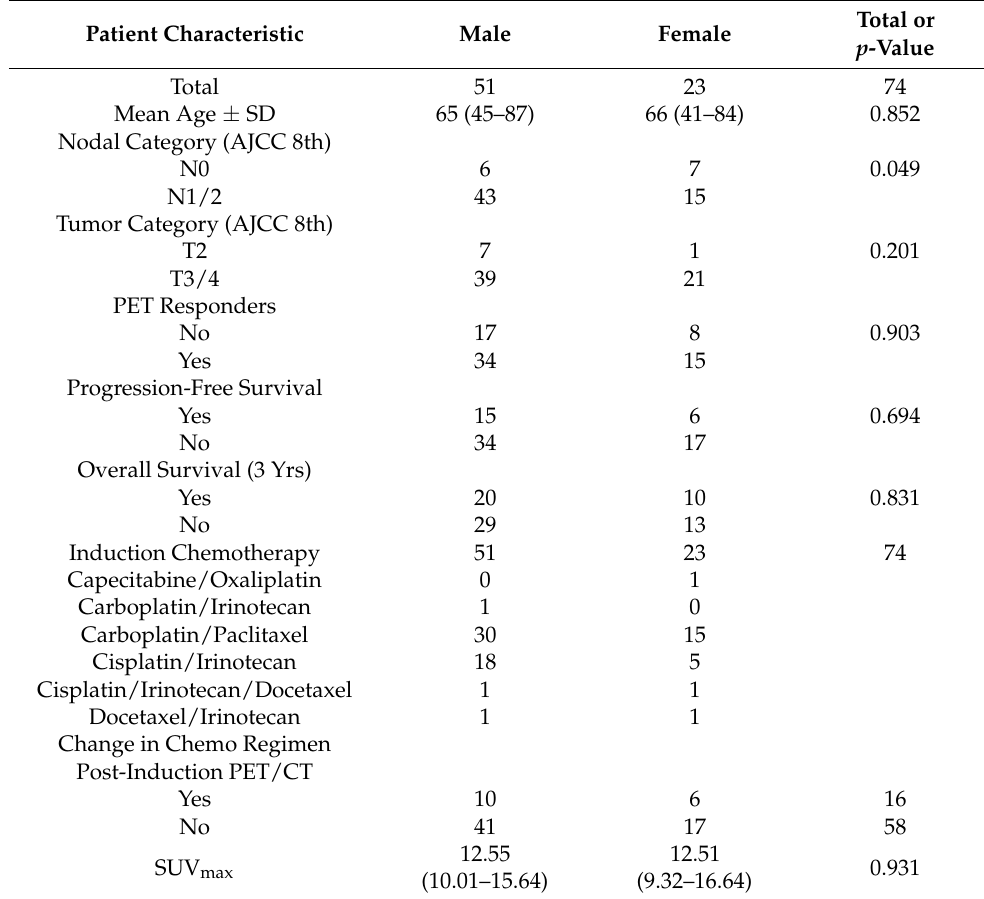
Table 2. Patient